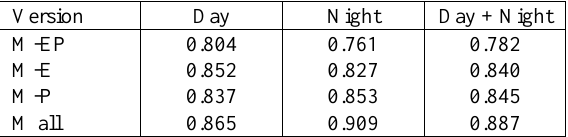
Table 3. Comparison of animal detection by F-measure among